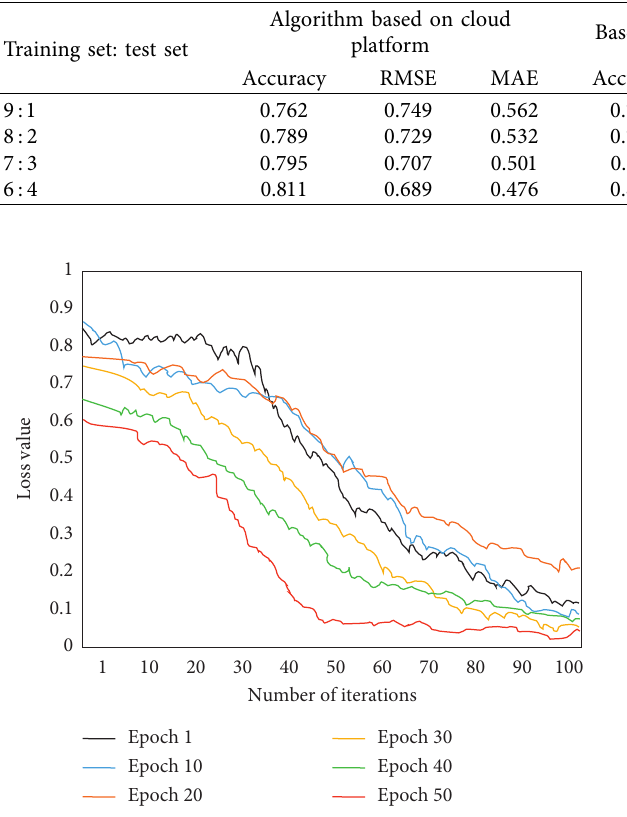
Figure 8: The training process of this model.